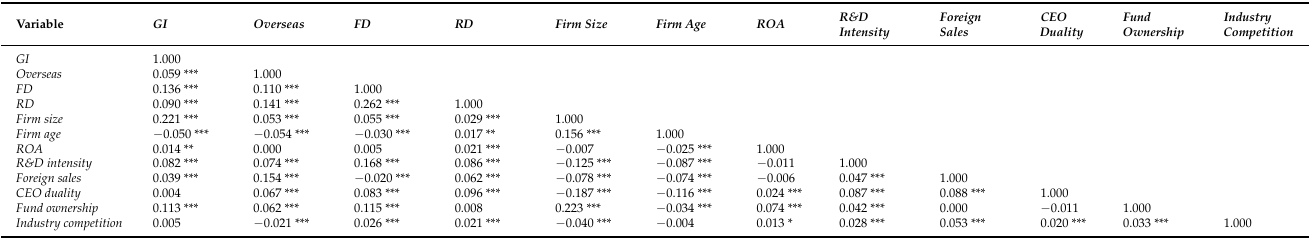
Table 3. Correlation